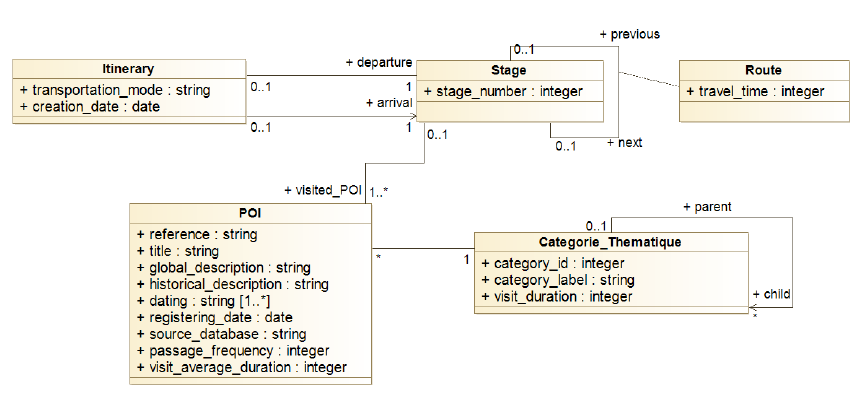
Figure 10. Itinerary